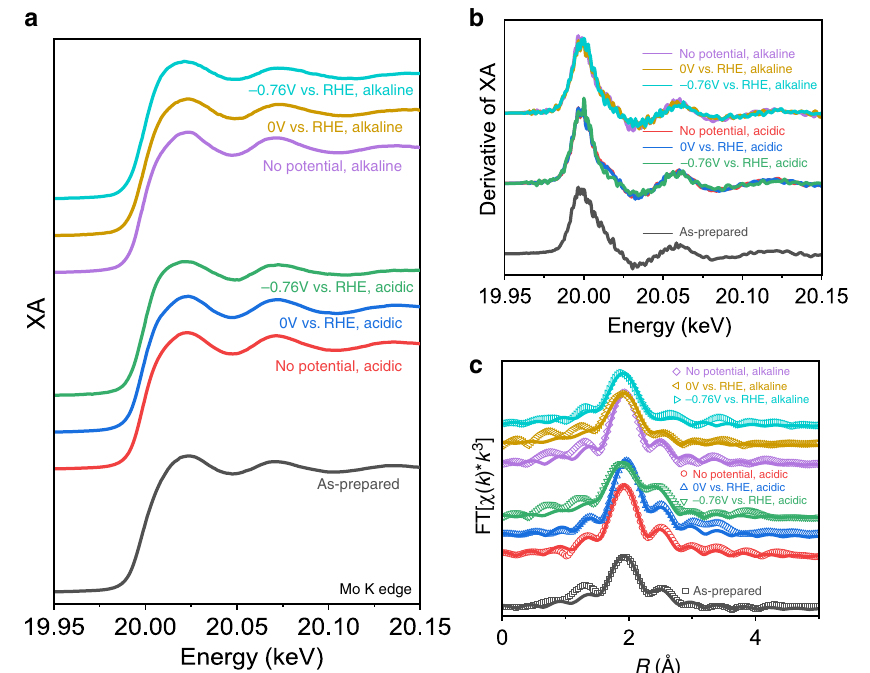
Fig. 3 In situ XAS at Mo K-edge. a XANES spectra, b fi rst-derivative spectra, and c Fourier-transformed R-space spectra (open points) and fi ts (solid lines) of Ni@1T-MoS 2 .